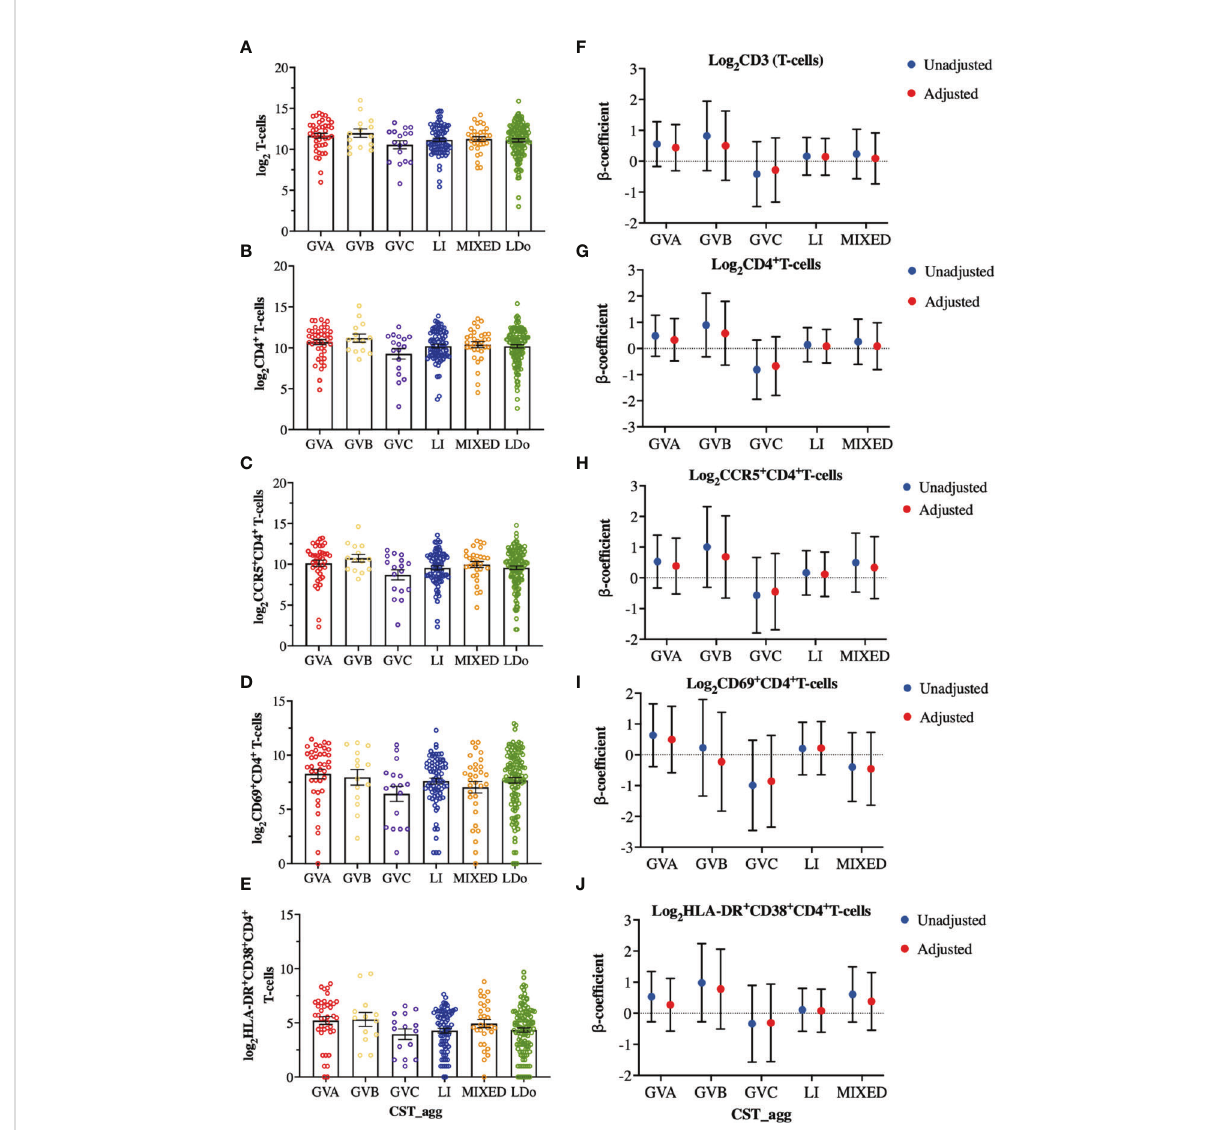
FIGURE 6 Comparison of cervical T-cell and subsets cell counts among the different cervicovaginal microbial groupings. log2-transformed cervical counts of (A) CD3 (T-cells), (B) CD4 + T-cells (C) CCR5 + CD4 + T-cells, (D) CD69 + CD4 + T-cells and (E) HLA-DR + CD38 + CD4 + T-cells. Linear mixed model analysis of the association between speci fi c cervicovaginal microbial communities (CST_agg) and log2-transformed cell counts of (F) CD3 (T- cells), (G) CD4 + T-cells (H) CCR5 + CD4 + T-cells, (I) CD69 + CD4 + T-cells and (J) HLA-DR + CD38 + CD4 + T-cells. b -coef fi cients represent the mean change in log2-transformed cell count associated with a speci fi c microbiome (CST_agg) when compared to Lactobacillus (non_iners) dominant (LDo) microbial communities. Blue symbols represent unadjusted models only utilizing microbial groupings as predictors. Red symbols represent models following multivariable adjustment for hormonal contraceptive type, HSV- 2 seropositivity at baseline, concomitant vulvovaginal candidiasis, age, use of BV antibiotics, use of other antibiotics, and use of antifungals prior to sample collection. The error bars in the raw cell count panels represent the standard error of the mean. The error bars from the linear mixed models represent the 95% con fi dence intervals associated with the